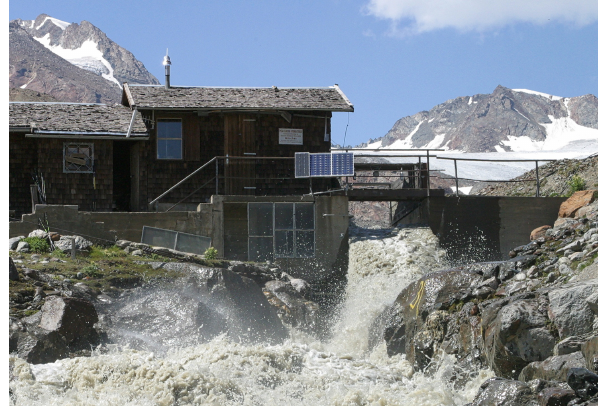
Figure 13. The Vernagtbach gauging station in 2006 (2635ma.s.l., 46.85675 ◦ N, 10.82886 ◦ E), view to the northwest. Photo by Lud- wig Braun.